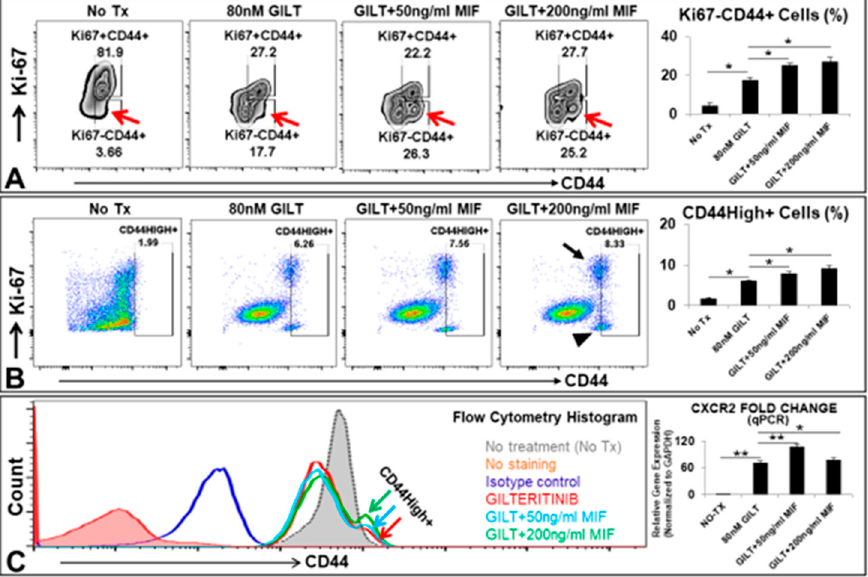
Figure 3. MIF promoted the survival of a group of CD44High+ cells after TKI treatment in vitro. ( A ) Representative FC plots of Ki-67 and CD44 expressions in MV4-11 experimental groups after 5 days’ sequential coculture of 80nM GILT and appropriate doses of MIF in vitro; Red arrow indicates viable Ki-67-CD44+ cells; Right bar chart: Cumulative FC percentage data of viable Ki-67-CD44+ cells; ( B ) Representative FC plots of Ki-67 and CD44 expressions in MV4-11 experimental groups after 5 days’ simultaneous coculture of 80 nM GILT and appropriate doses of MIF in vitro; Black arrow or arrowhead indicates Ki-67+CD44+ or Ki-67-CD44+ cell population respectively; Right bar chart: Cumulative FC percentage data of viable CD44High+ cells; ( C ) Representative FC histogram plot of CD44 expression in MV4-11 experimental groups after 5 days’ simultaneous coculture in vitro; Color arrows indicate groups treated with 80 nM GILT alone or its combination with different doses of MIF, showing GILT-treated groups with the supplementation of MIF had a group of CD44High+ cells when compared to the non-treatment control or GILT alone; Right bar chart: qPCR Data show the change of mRNA expression of CXCR2 gene in MV4-11 cells at different doses of MIF combined with 80 nM GILT in vitro; * p < 0.05, ** p < 0.01.